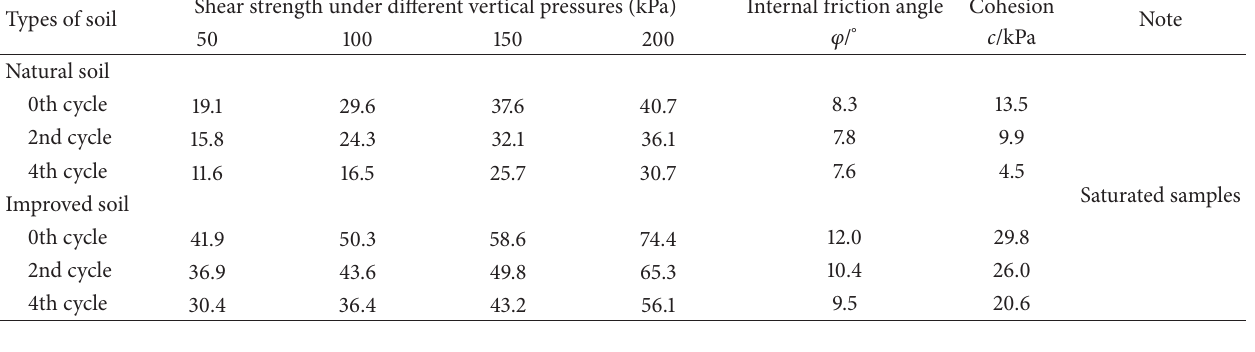
Table 4: The results of shear strength parameters during cyclic wetting-drying process.